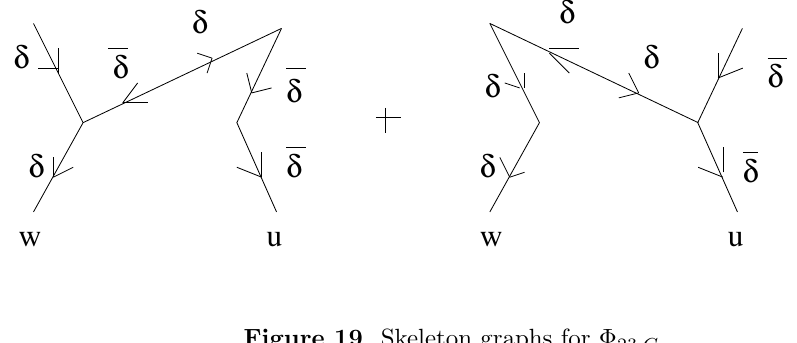
Figure 19 . Skeleton graphs for (cid:8) 23 ;C .